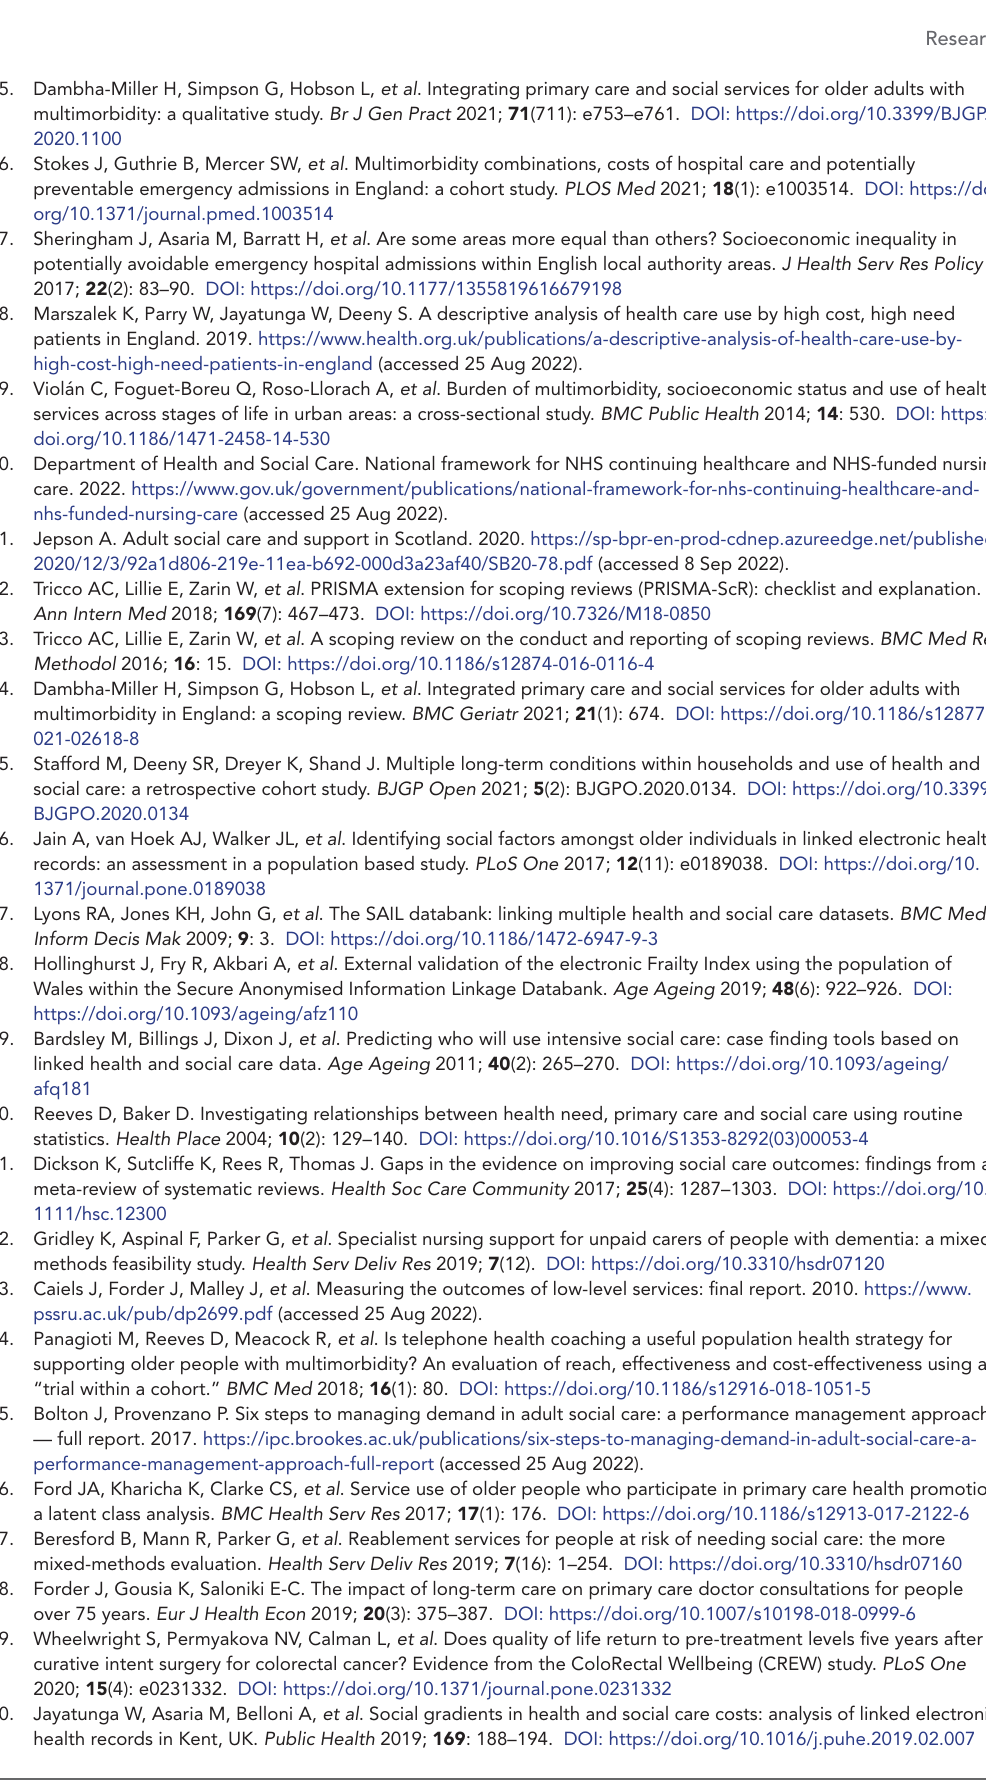
Simpson G et al . BJGP Open 2022; DOI: